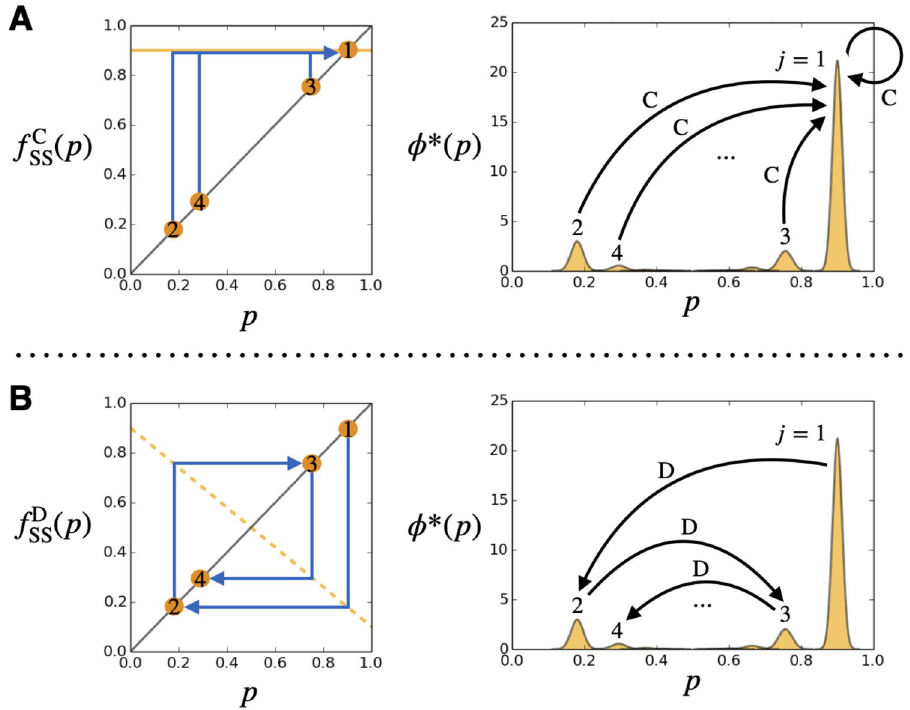
SS . ( A ) In the left panel, the yellow solid = e 2 . This mapped value is labeled as µ 1 . − SS , where the peak = 1 of class- ( j + 1 ) by the D-map. +